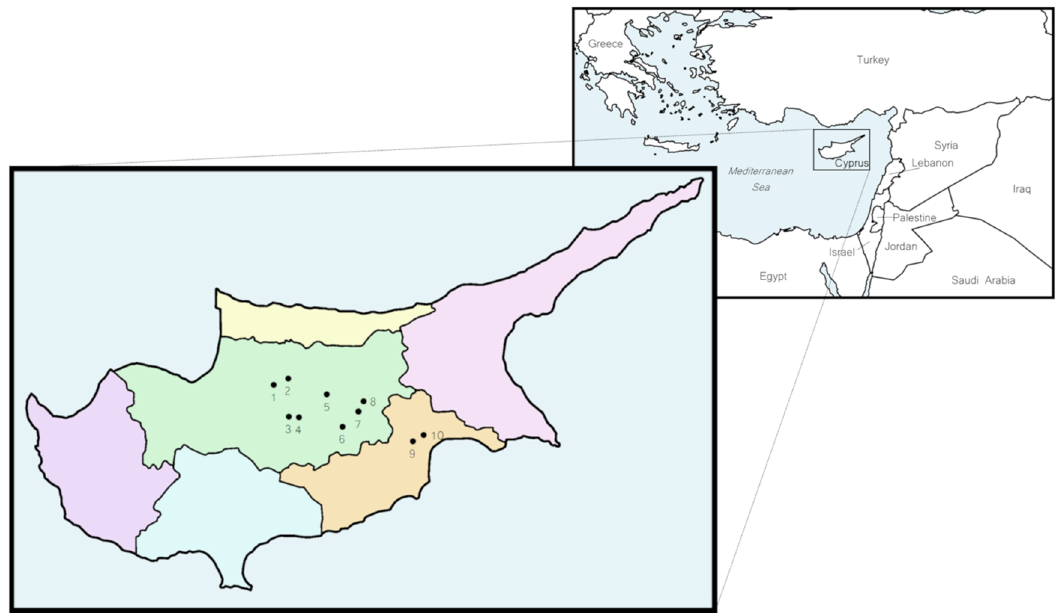
Figure 1. Geographic location of Cyprus in the East Mediterranean region and distribution of the cattle farms sampled. Farms 1–8 were located across the Nicosia district (green), while farms 9–10 were located in the Larnaca district (orange).